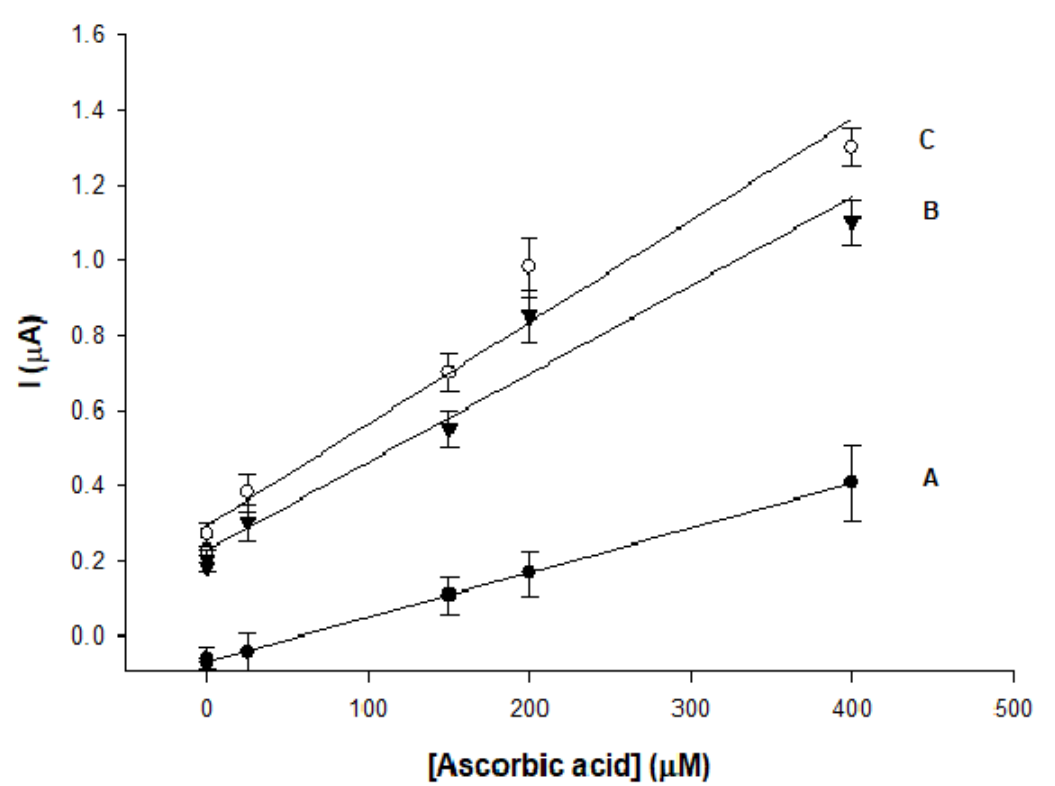
Figure 8. Calibration curves of Au bare ( A ), Au/SWCNTS ( B ) and h-nPG ( C ) modified electrodes in 0.1 M PBS pH = 7.4, KCl = 0.1 M.